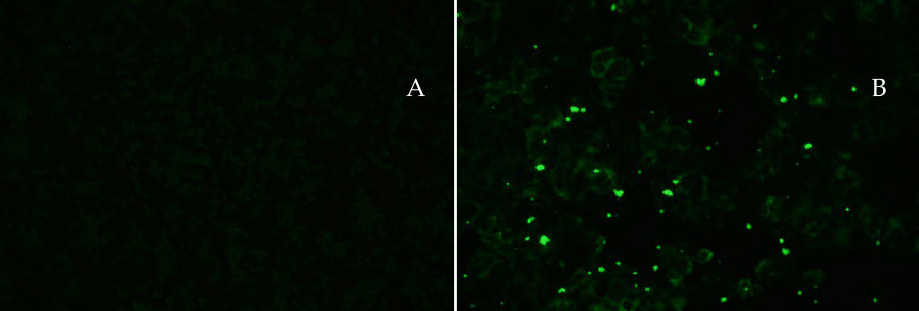
Figure 2. Indirect immunofluorescence using polyclonal antibodies specific for YFV in C6/36 cell cultures: ( A ) negative control; ( B ) positive saliva pool sample (1AALS) on 14 dpi. The magnification is 200×. Table 1. Ae. albopictus batches, dpi, cell culture results, and RT–qPCR quantification of YFV.